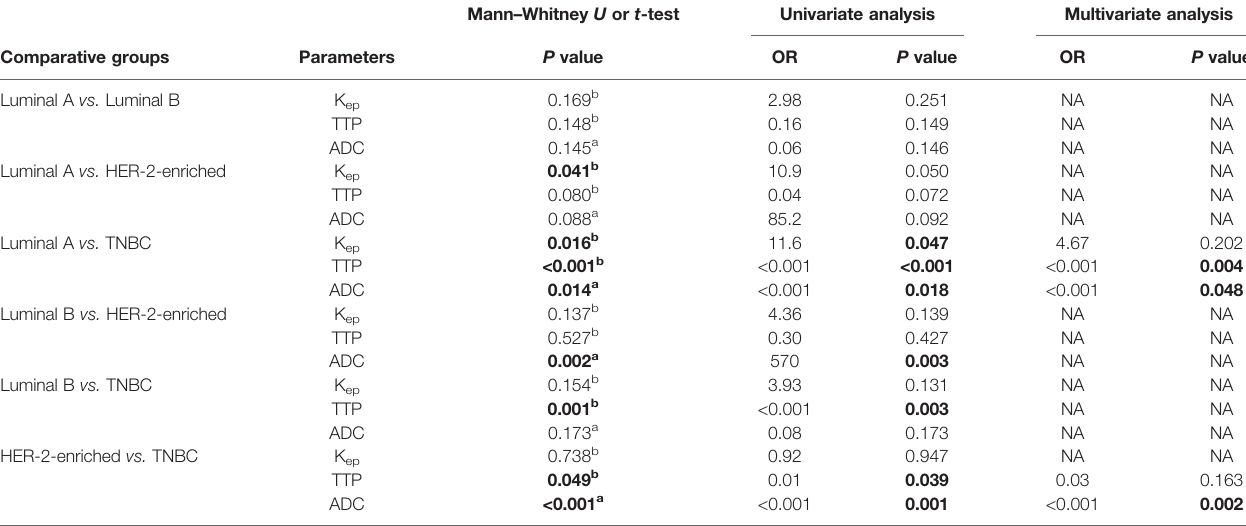
TABLE 4 | Ppairwise comparison analysis of the parameters in different subtypes.